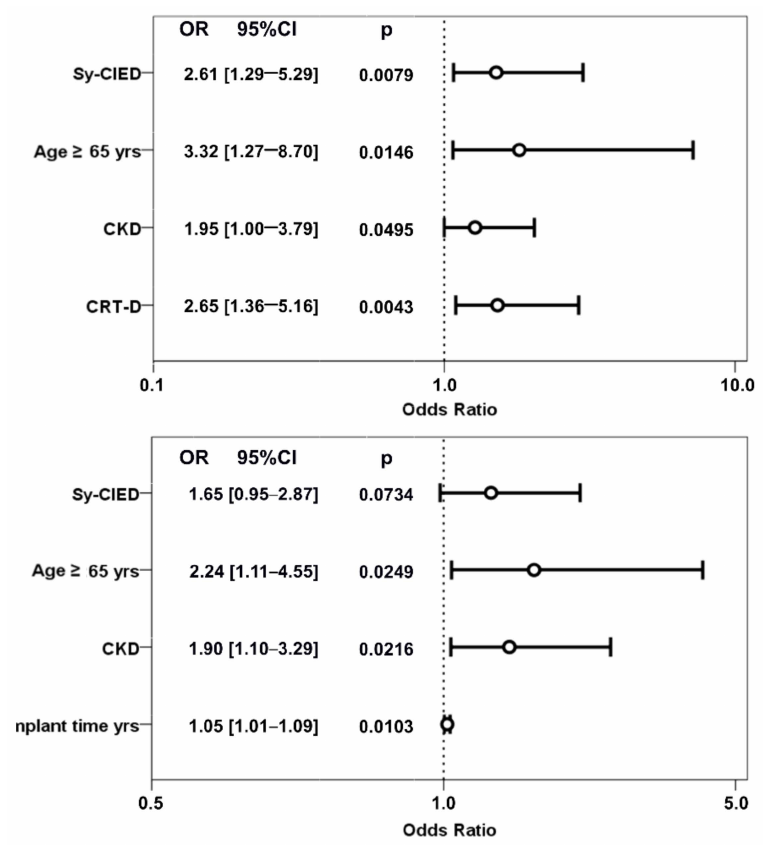
Figure 3. Independent predictors of in-hospital overall mortality and major complications among patients with CIEDI. Legend: CI = confidence intervals; CKD = Chronic Kidney Disease; CRT-D = implantable defibrillator with resynchronization function; HR = hazard ratio; Lo-CIEDI = local CIED infection; Sy-CIEDI = systemic CIED infection; TLE = transvenous lead extraction; yrs = years.